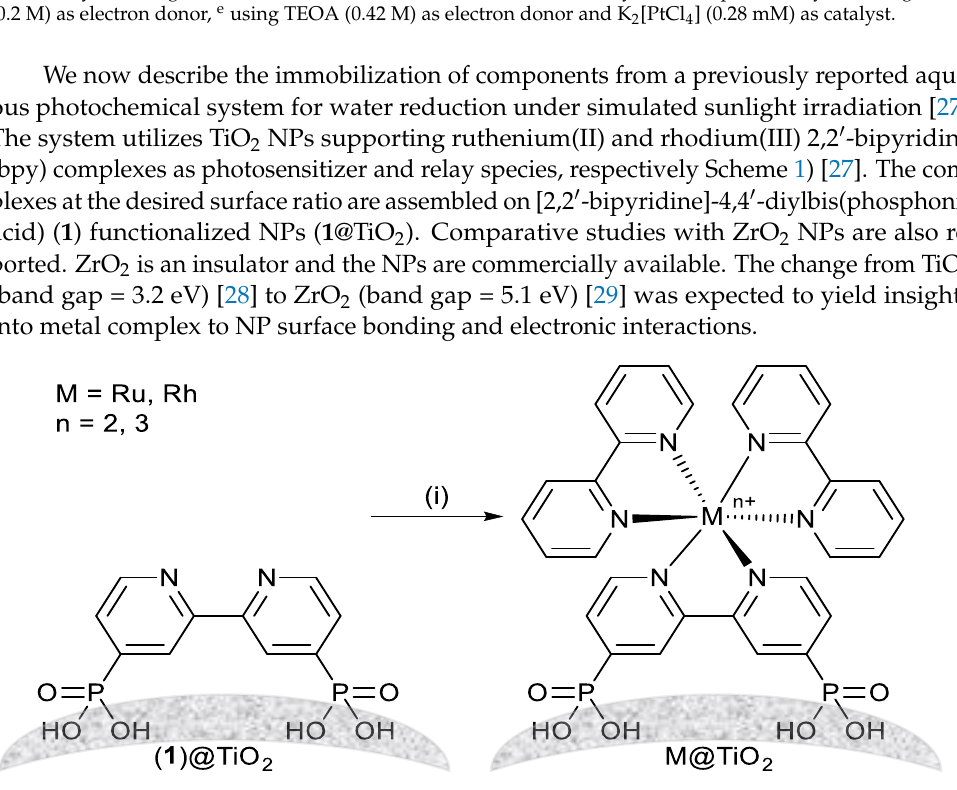
Scheme 1. Assembly of metal complexes on TiO 2 NPs starting from NPs functionalized with 1 . Conditions: (i) MCl 3 ·3H 2 O (M = Ru or Rh), bpy, EtOH: H 2 O, 160 °C, autoclave, 1 h.